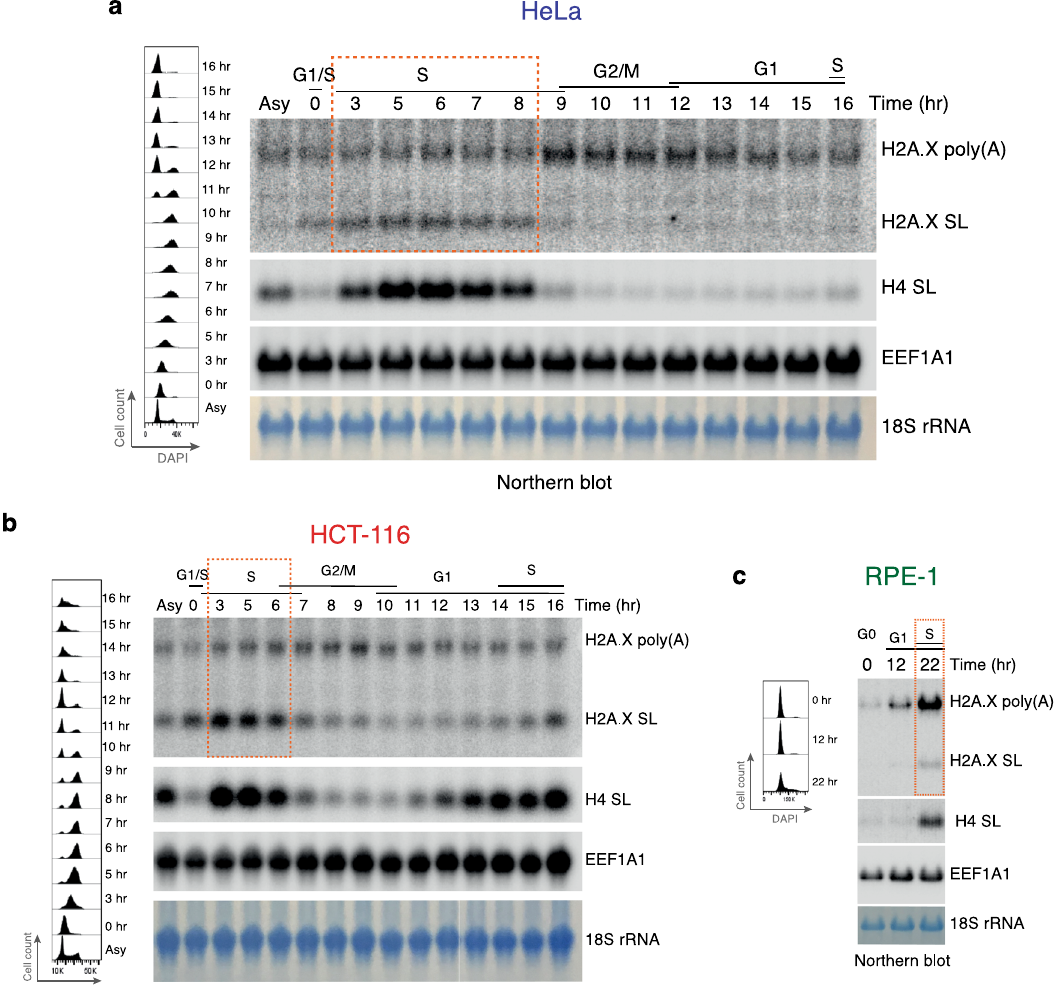
Fig. 3 Comparative H2A.X mRNA cell cycle distributions. a Cell cycle synchronisation of HeLa cells by double thymidine block (DTB). Cell cycle pro fi les (time following DTB release) showing DAPI fl uorescent intensity on x-axis and cell count on y-axis (left). H2A.X mRNA northern blot of total RNA (right). Asy: asynchronous cells. Cell cycle phases determined by fl ow cytometry are indicated. H4 SL: core H4 histone SL mRNA. EEF1A1 mRNA and 18S rRNA used as loading controls. Orange box: S-phase. b As in a but for HCT-116 cells. c Cell cycle pro fi les of RPE-1 cells synchronised by contact inhibition (time after block release indicated) showing DAPI fl uorescent intensity on x-axis and cell count on y-axis (left). H2A.X mRNA northern blot of total RNA from synchronised RPE-1 cells (right). H4 SL: core H4 histone SL mRNA. EEF1A1 mRNA and 18S rRNA used as loading